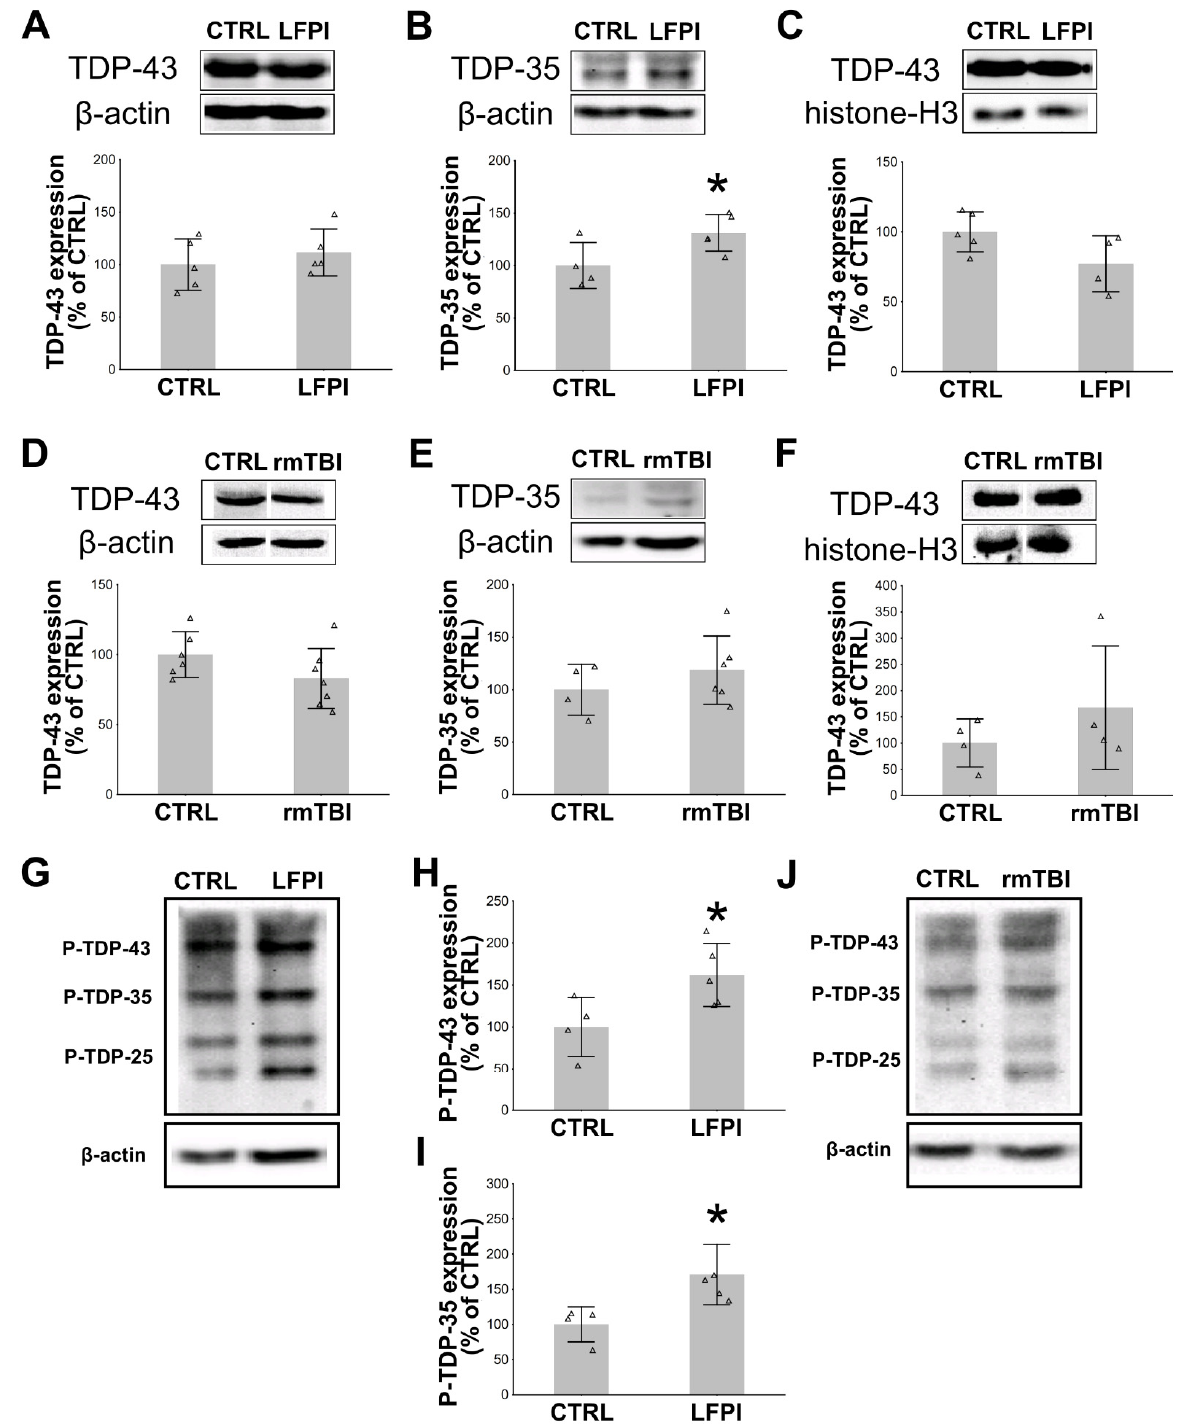
Figure 4. Effects of single moderate lateral fluid percussion injury (LFPI) or repetitive mild traumatic brain injury (rmTBI) on the subcellular localization and cleavage of transactive response (TAR) DNA binding protein 43 (TDP-43) and the production of phosphorylated TDP-43 species in the mouse hippocampi at 14 d after the experimental brain trauma protocols: ( A – F ) Representative immunoblots of TDP-43, β -actin, and histone-H3 and the bar plots of their corresponding densitometric analyses of the cytoplasmic ( A , D ) and the nuclear ( C , F ) TDP-43 expression levels in the animals of the related control groups (CTRL) and mice sacrificed at 14 d after LFPI or the last mild trauma. Additionally, analysis of the cytoplasmic TDP-35 expression was done in the hippocampal samples from the animals exposed to LFPI ( B ) or rmTBI trauma procedures ( E